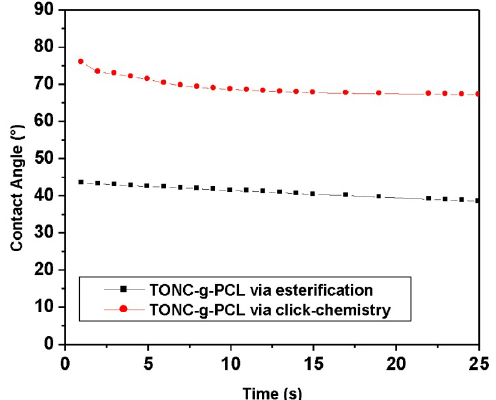
Figure 10. Contact angle vs. time performed with water for grafted TOCN